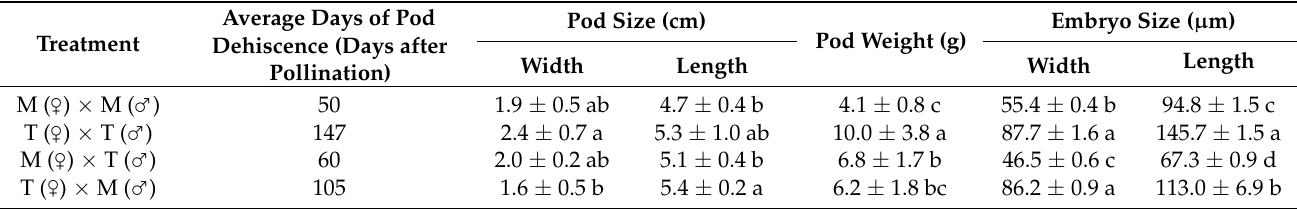
Table 2. Period of pod dehiscence and characteristics of intra- and interspecific hybridization between Phaius mishmensis (M) and Phaius tankervilliae (T).